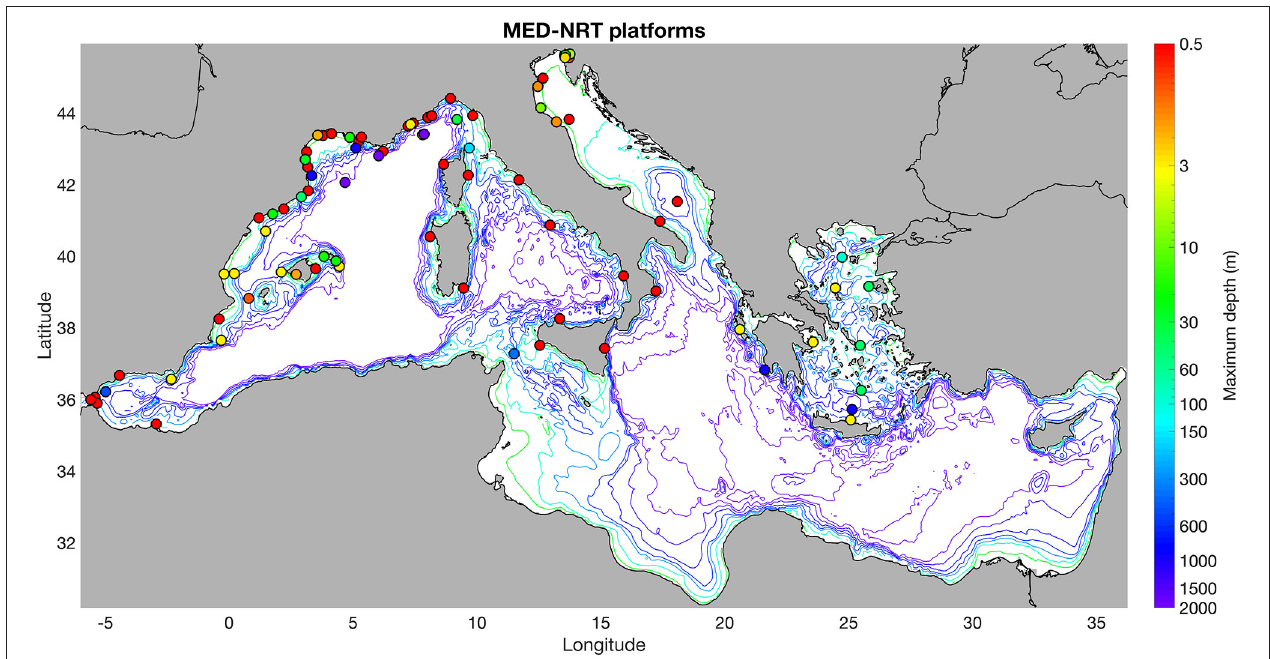
FIGURE 1 | MED-NRT data set: fixed platforms and their maximum sensors’